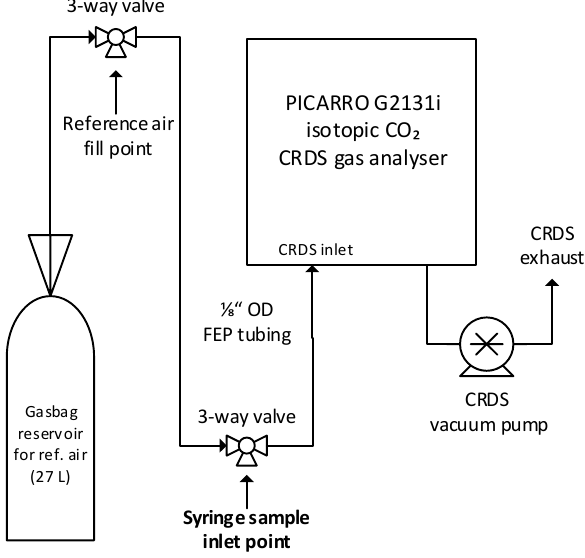
Figure 1. Schematic diagram of the discrete gas sample measure- ment system coupled to the isotopic-CO 2 CRDS analyser.